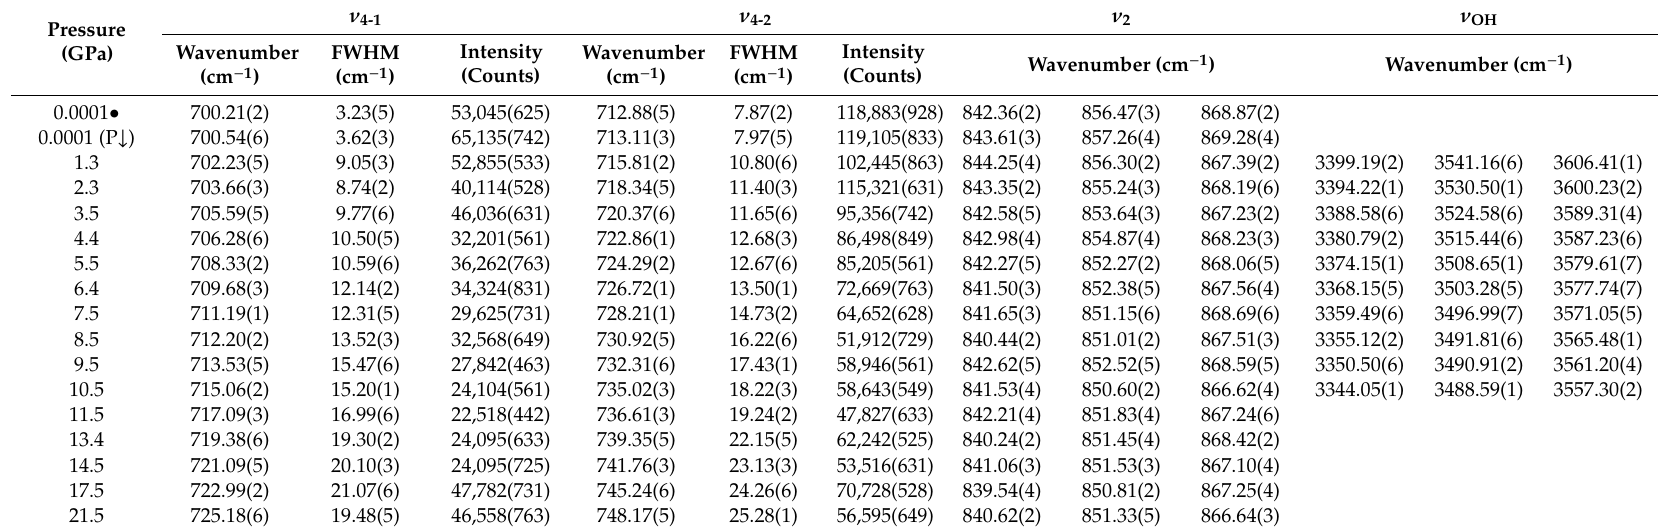
Table 2. Wavenumber, full width at half maximum (FWHM) and intensity of infrared modes of aragonite versus